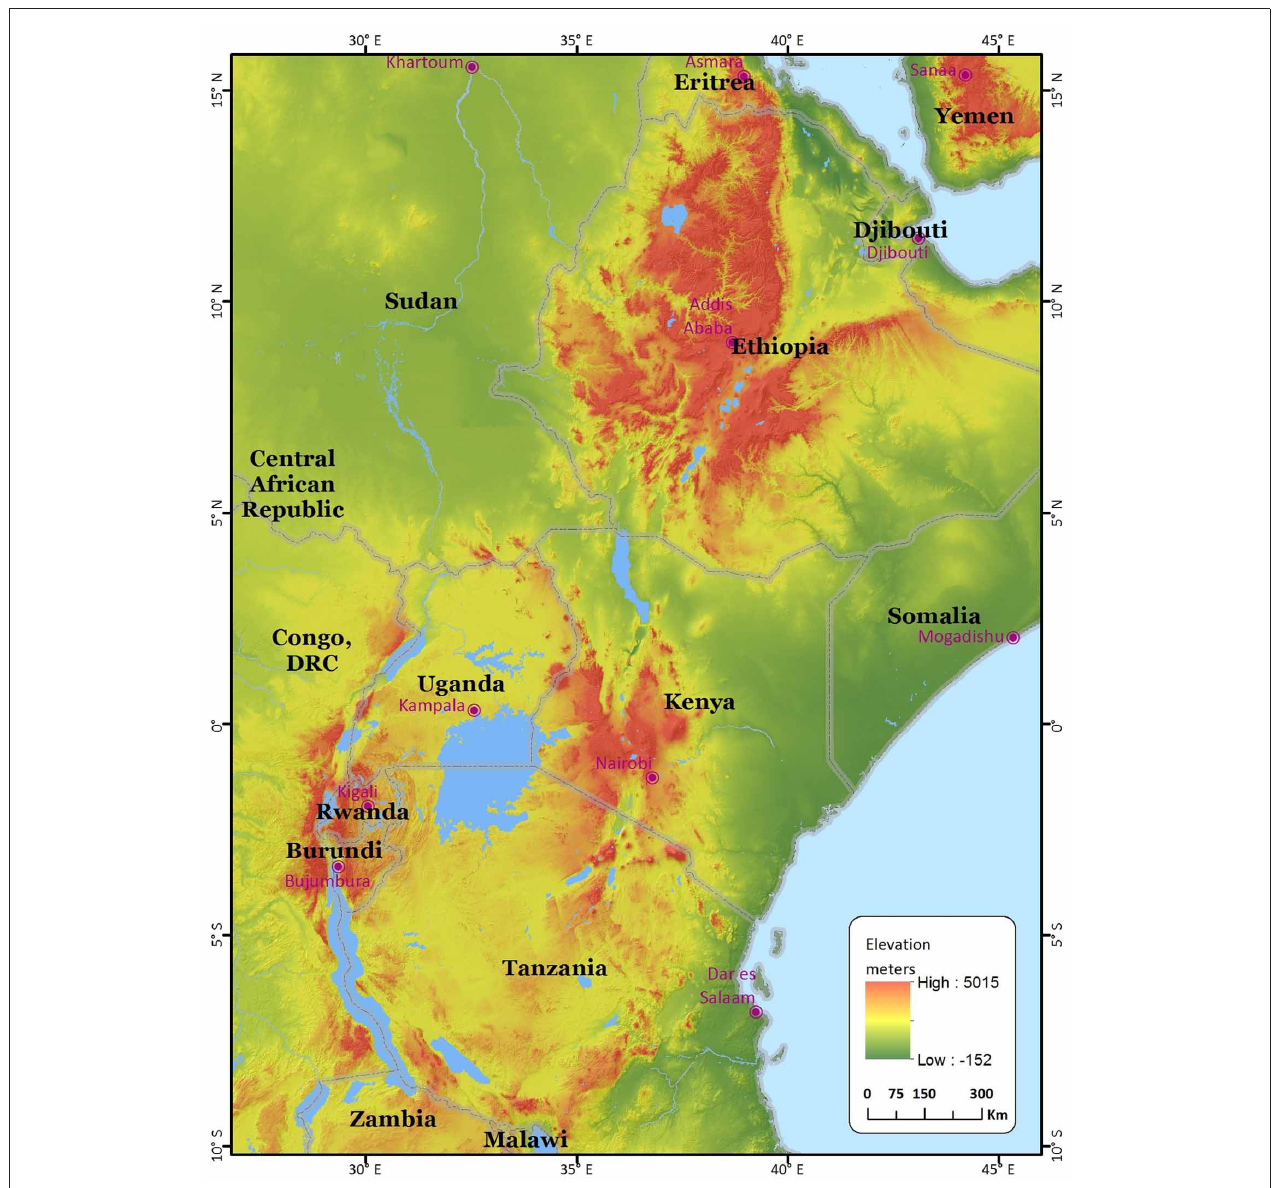
FIGURE 1 | Highlands areas in East African